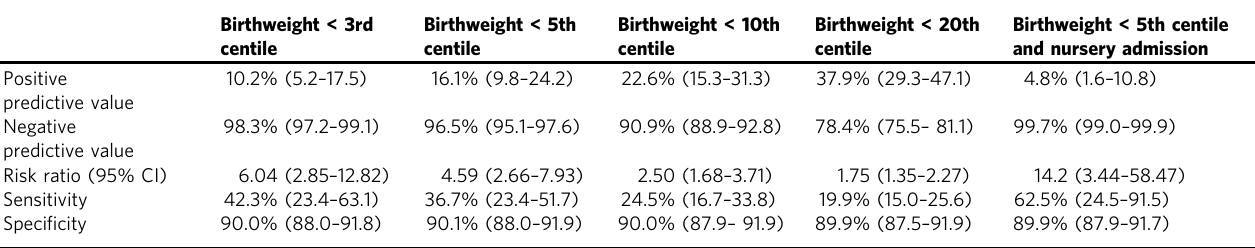
Table 1 Diagnostic performance of circulating SPINT1 concentrations at 35 + 0 – 37 + 0 weeks ’ gestation to identify fetuses born at varying low birthweight cut-offs.